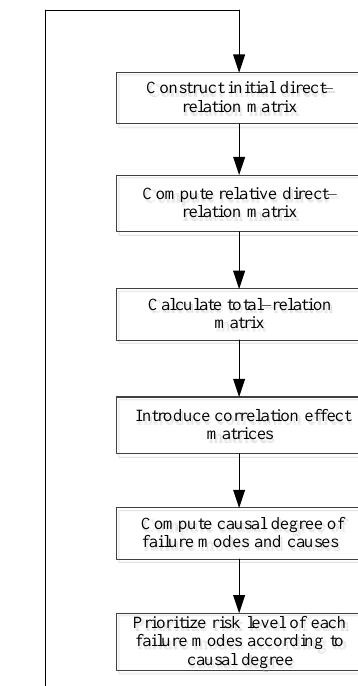
Table 5. Failure mode and effects analysis (FMEA) of the propulsion subsystem for a shipboard IEPS. Equipment